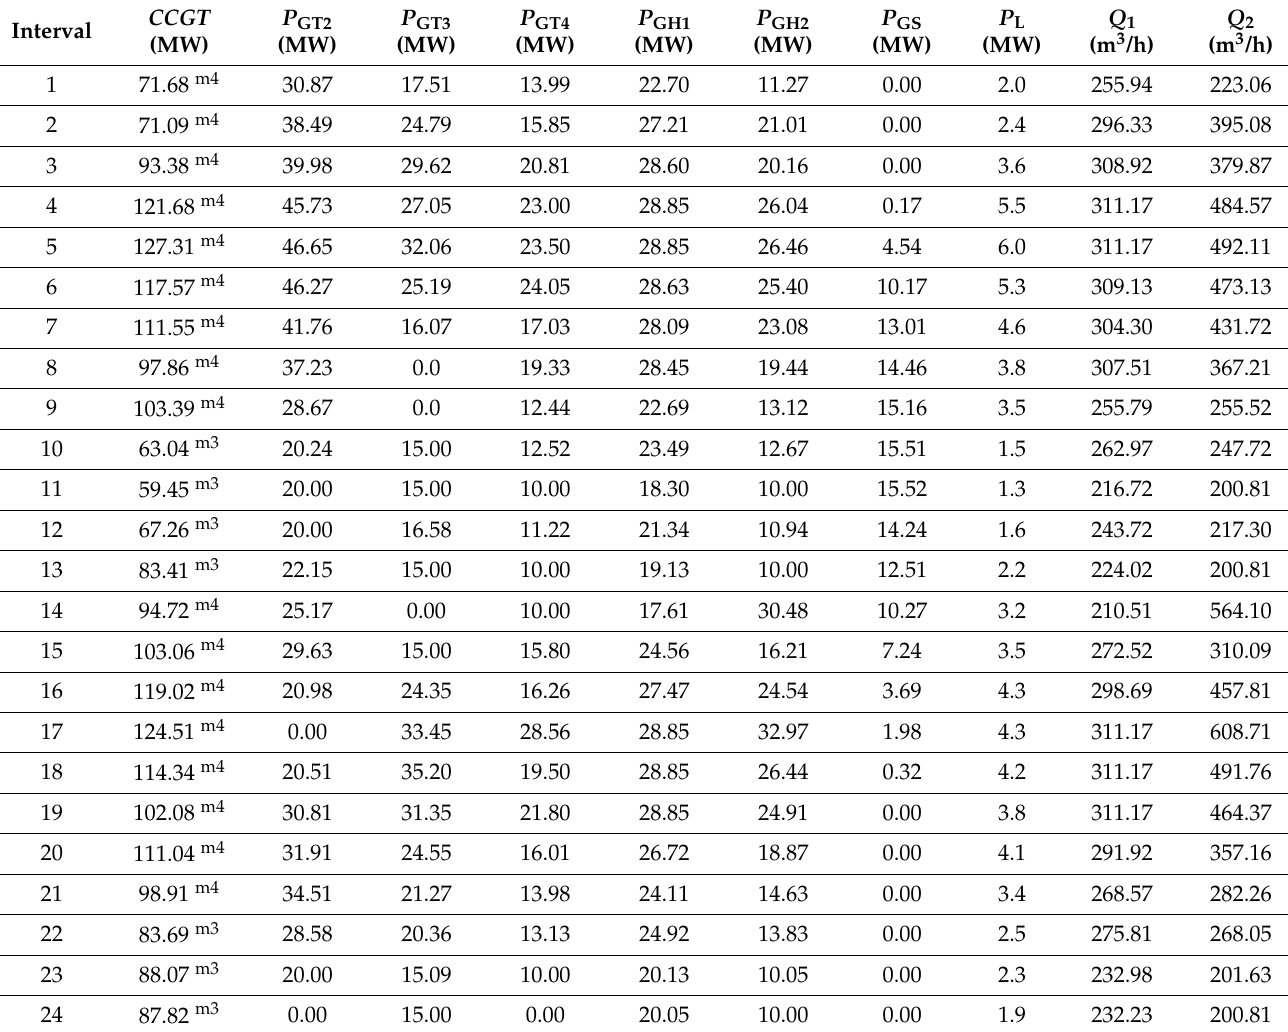
Table 12. Optimal generation scheduling using SAGA for case